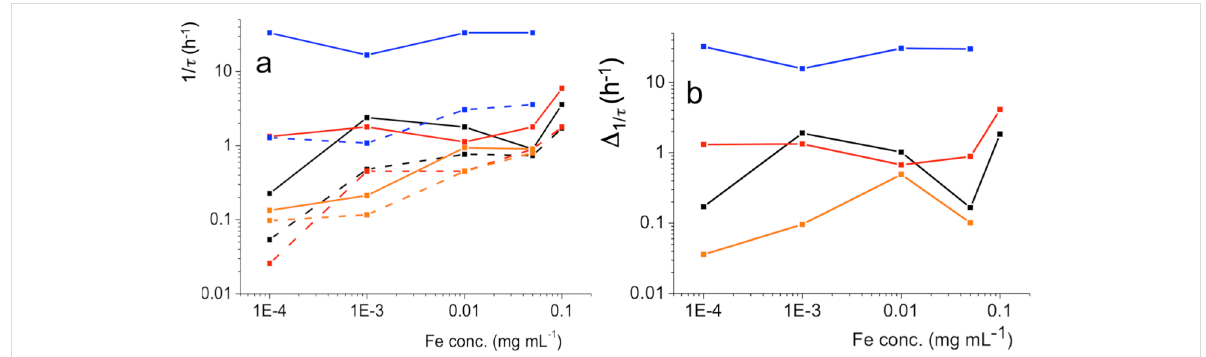
Figure 5: a) Variation of the inverse of the characteristic adsorption time (1/ τ ) of the IONPs grafted with dendrons (C 2 H 5 OEG 8 Den: black; C 2 F 5 OEG 8 Den: red; C 4 H 9 OEG 8 Den: orange; C 4 F 9 OEG 8 Den: blue) at the air (dashed) and F -hexane-saturated air (solid line)/aqueous phase inter- face. b) Variation of the differences of 1/ τ measured under air and F -hexane-saturated air ( Δ 1/ τ ) as a function of the Fe concentration (same color